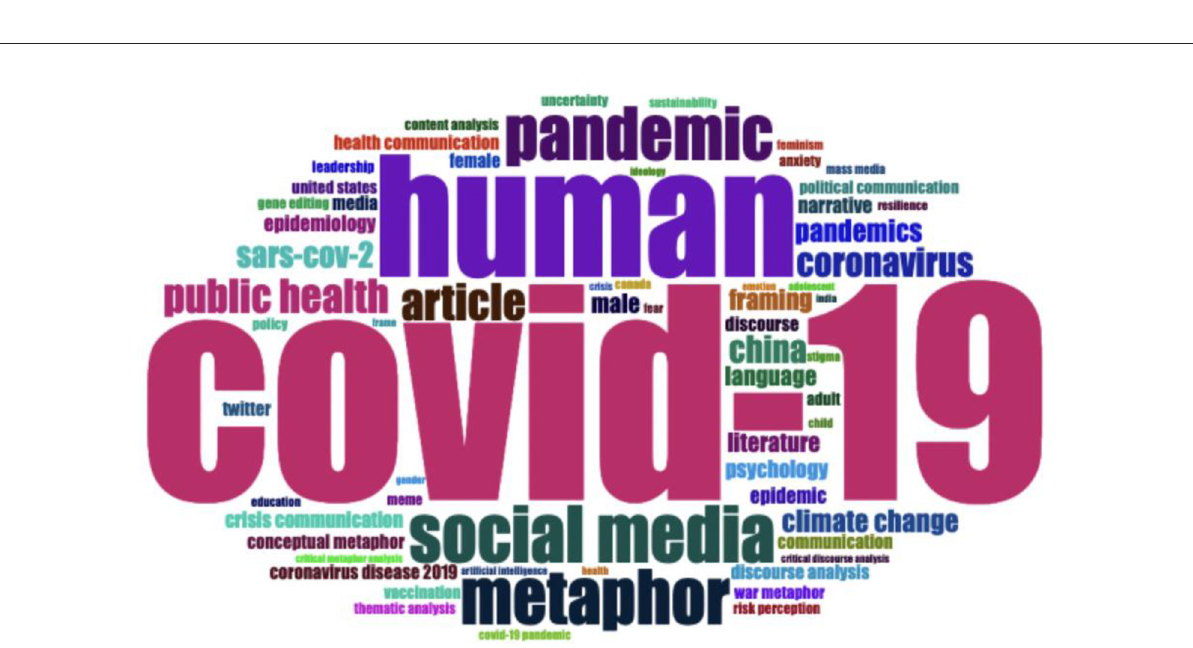
FIGURE7 A word cloud of the 65 most frequently used research